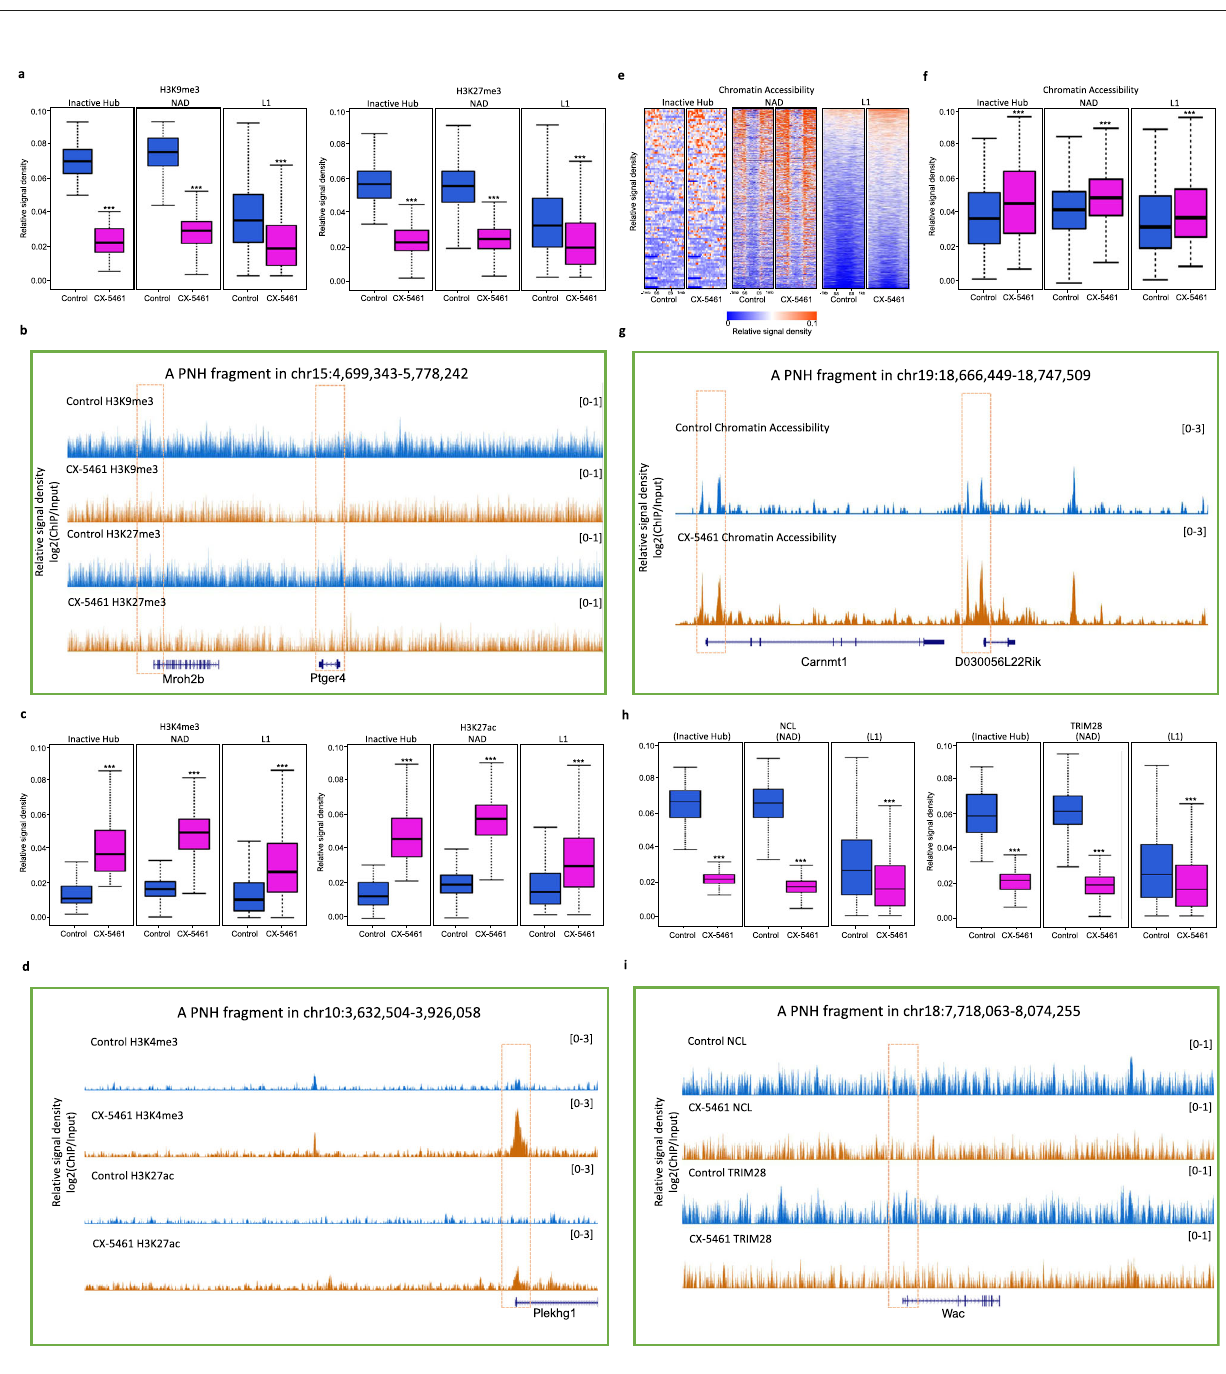
Fig. 3 De fi ciency of rRNA biogenesis disrupted the normal state of nucleolar LLPS. a CX-5461 treatment causes abnormal nucleolar structure with electron microscopy; Experiment was repeated independently three times with similar results. b Immuno fl uorescence staining of NCL in control mES cells and CX-5461-treated mES cells; Experiment was repeated independently three times with similar results. c Immuno fl uorescence staining of NPM1 in control mES cells and CX-5461-treated mES cells; Experiment was repeated independently three times with similar results. d Immuno fl uorescence staining of FBL in control mES cells and CX-5461 treated mES cells; Experiment was repeated independently three times with similar results. e Immuno fl uorescence staining of RPA194 in control and CX-5461 treated mES cells; Experiment was repeated independently three times with similar results. f FRAP analysis showing CX-5461 treatment causes accelerated recovery after photobleaching of NCL; N = 3 biologically independent experiments; Data are presented as mean values + / − SEM. SEM standard error of mean. Shown images are representative of three times of biologically independent experiments. g FRAP analysis showing CX-5461 treatment causes accelerated recovery after photobleaching of NPM1; N = 3 biologically independent ChIP-seq experiments; Data are presented as mean values + / − SEM. SEM standard error of mean. Shown images are representative of three times of biologically independent experiments. h FRAP analysis showing CX-5461 treatment causes accelerated recovery after photobleaching of FBL; N = 3 biologically independent ChIP- seq experiments; Data are presented as mean values + / − SEM. SEM standard error of mean. Shown images are representative of three times of biologically independent experiments. Source data are provided as a Source Data fi